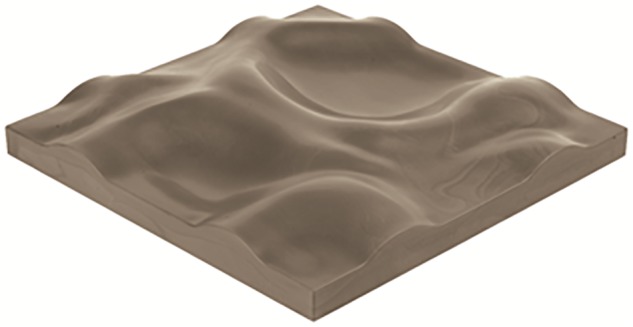
Artificial uneven surface. The terrasensa® foam panels consist of polyurethane with the following material properties: shore durometer hardness scale A (DIN 53505) = 50 ± 5; impact resilience (DIN 53512) R = 50.